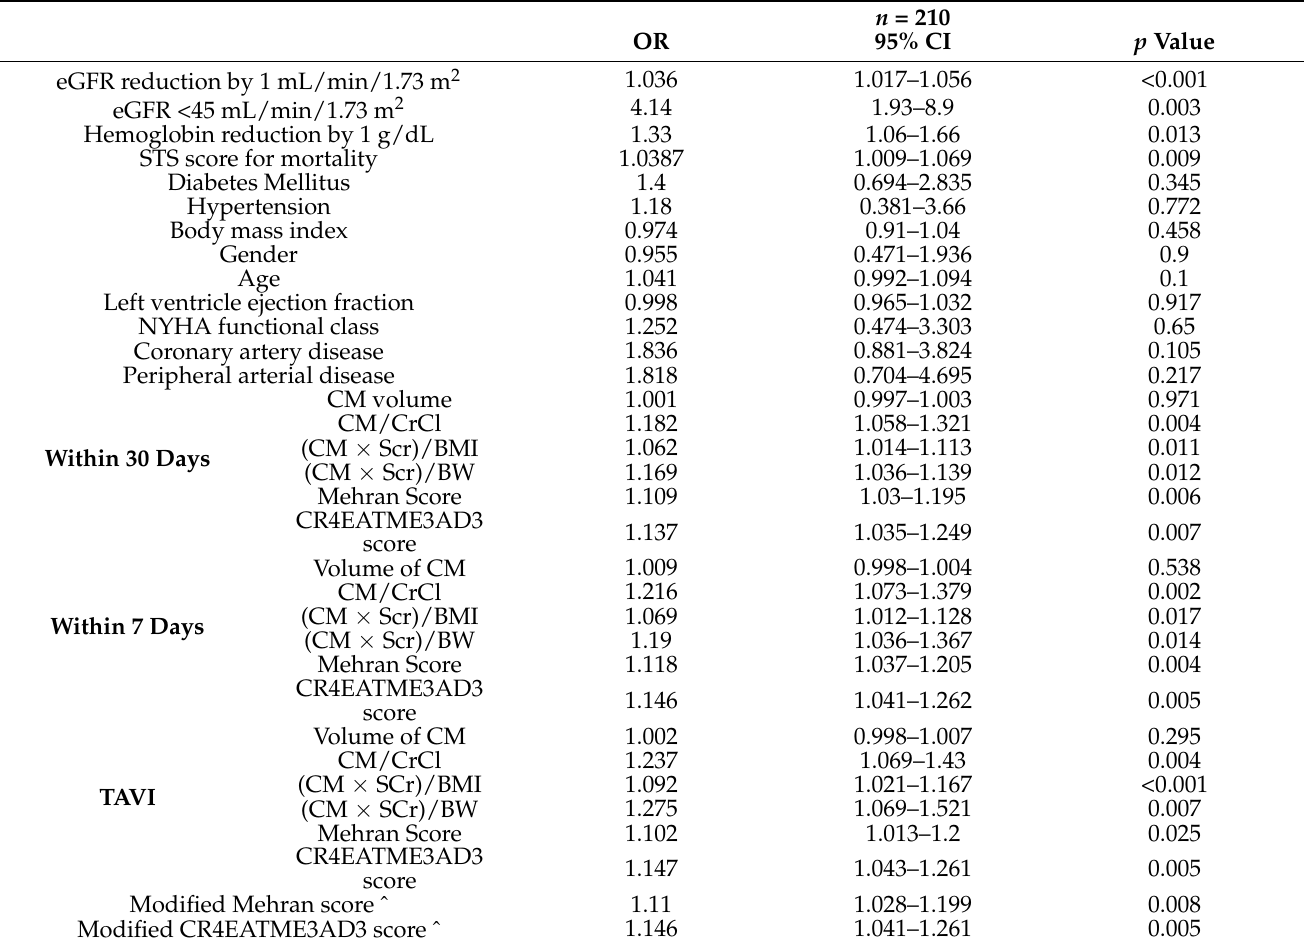
Table 4. Univariable logistic regression analysis for the probability of developing AKI following TAVI.